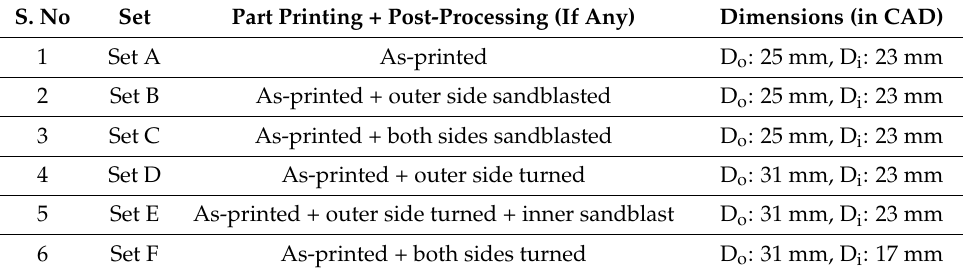
Table 3. The different sets of post-AM treatments completed.